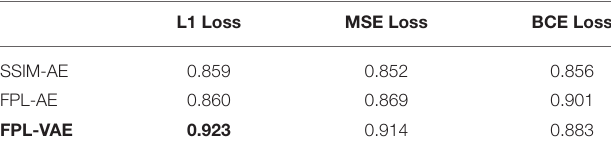
TABLE 3 | Model accuracy for anomaly detection based on different loss maps and network structures.